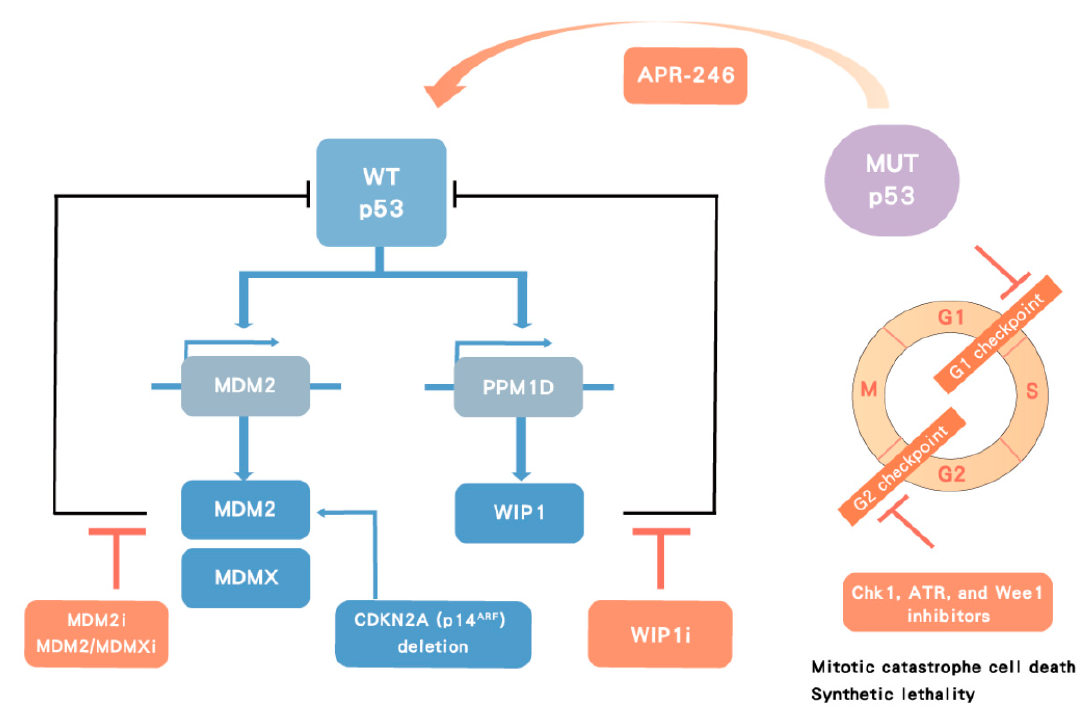
Figure 6. Therapeutic strategy targeting p53. In p53 wild-type (WT) cancers, p53 transactivates its negative regulators, MDM2 and wild-type p53-induced phosphatase 1 (WIP1), which in turn